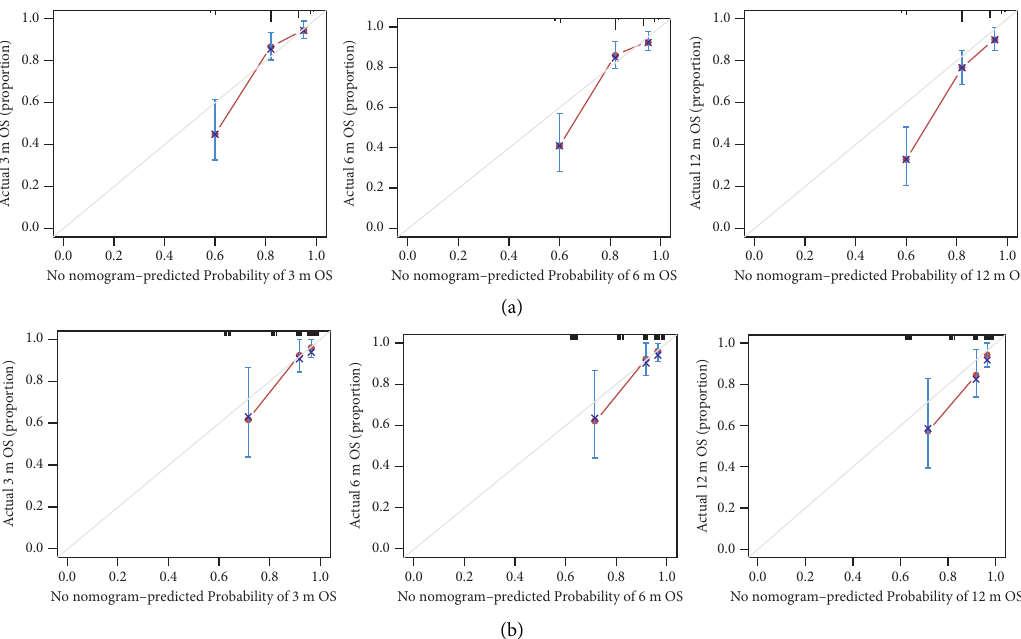
Figure 4: Calibration curve of the nomogram predicting 3-month, 6-month, and 12-month survival rates in the training cohort (a). Calibration curve of the nomogram predicting 3-month, 6-month, and 12-month survival rates in the validation cohort